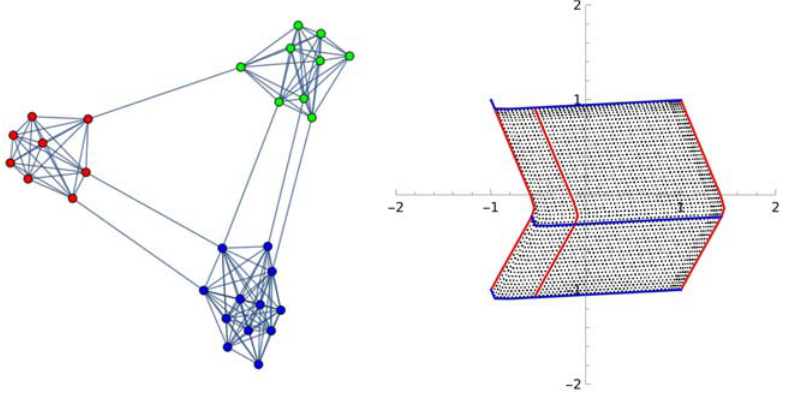
Figure 1: A graph with three well - separated clusters, and the image of its Fiedler -